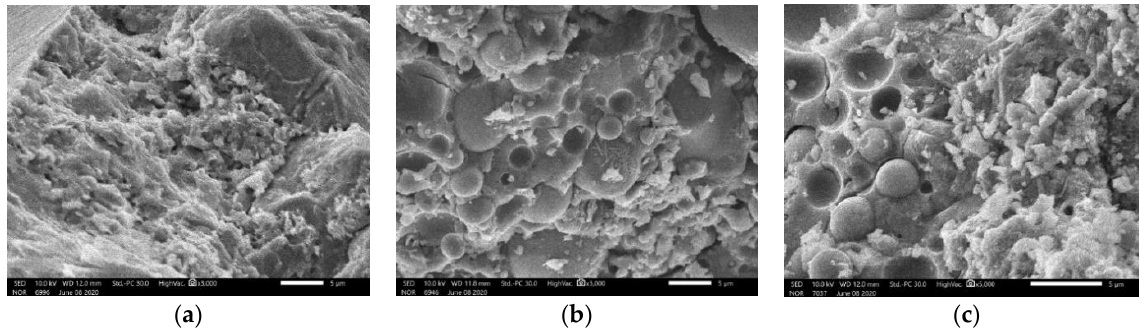
Figure 13. ( a ) FA completely reacted; ( b ) FA partially reacted (curing at ambient temperature); ( c ) FA partially reacted (curing with heating).